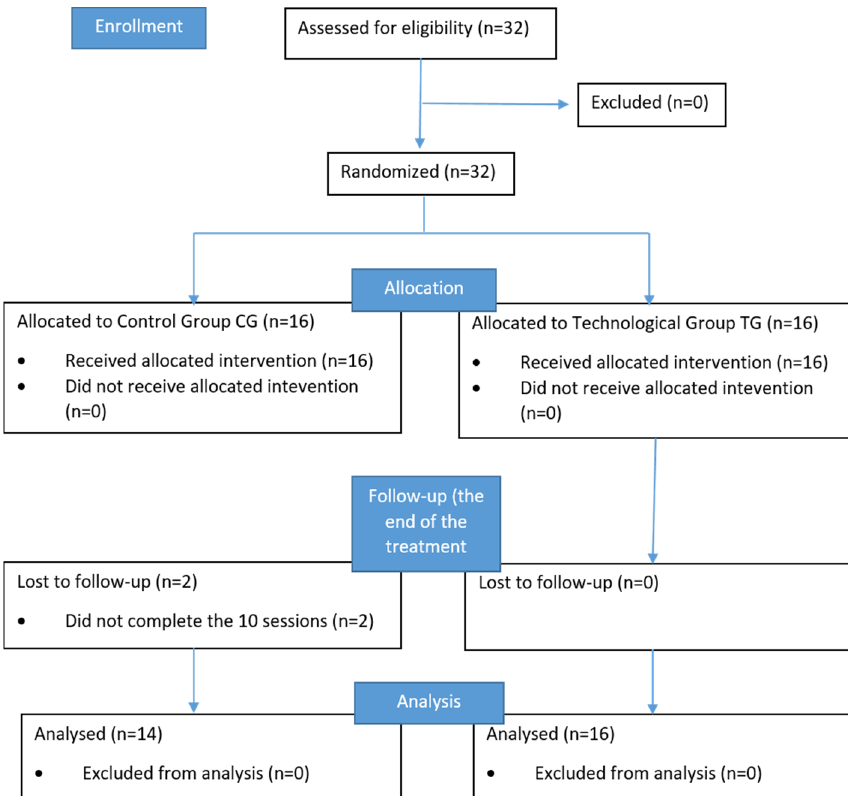
Figure 3. The CONSORT flowchart. At the baseline, no differences in the inclusion criteria value (Hoehn and Yahr score; ranking scale score; geriatric depression scale; functional ambulation category; mini men- tal state examination) and in the demographic characteristics (gender; age; marital status;